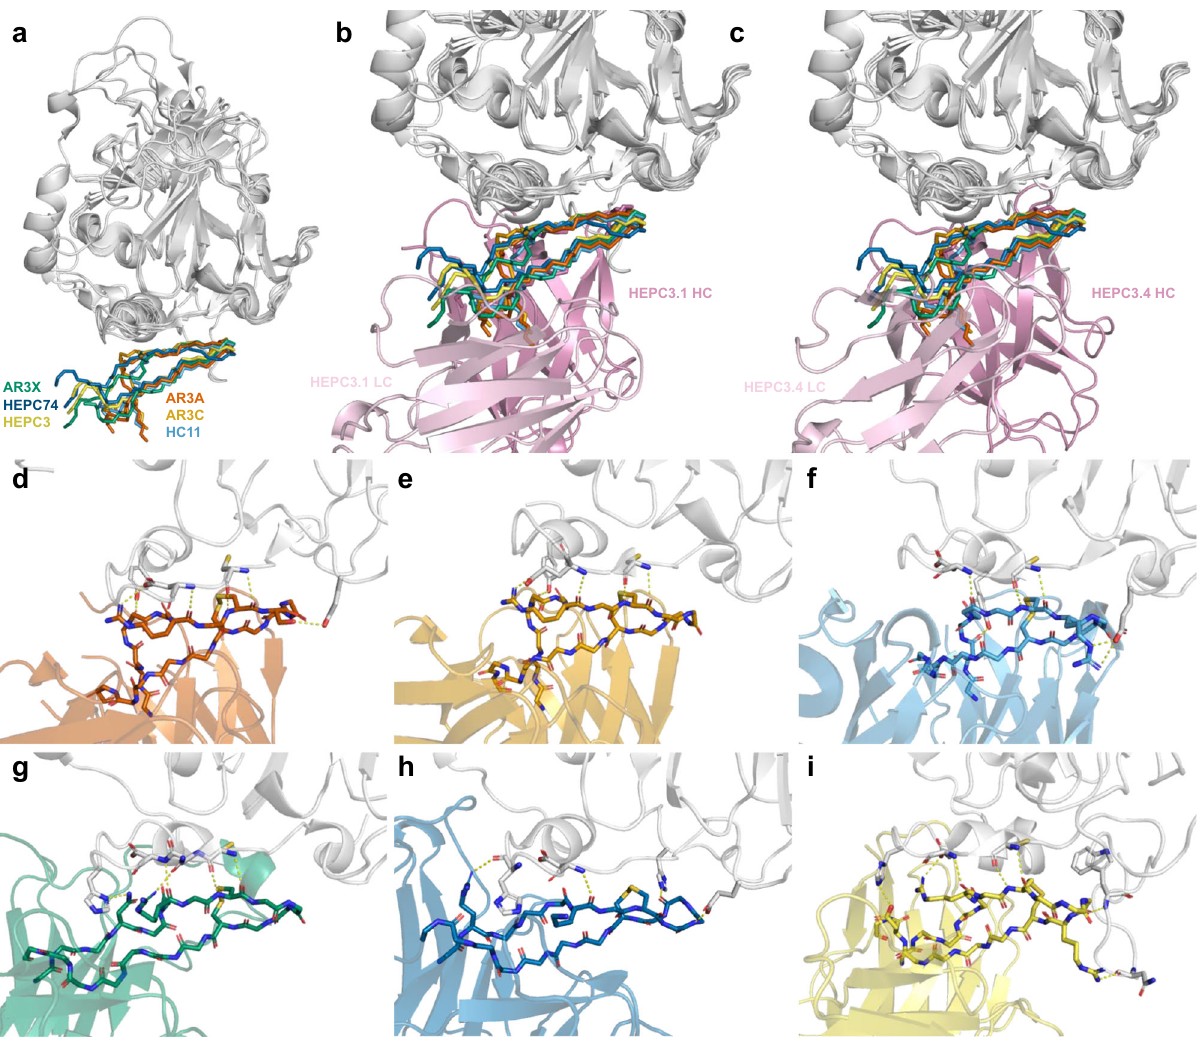
Fig. 4 Interactions of the HCV neutralizing V H 1-69 gene-encoded Abs encompassing a common HCDR3 disul fi de bond motif with the front layer of HCV glycoprotein E2. a All six Abs of the described family demonstrate the same pattern of antigen recognition mediated by their HCDR3 loop. Shown is the overlay of the HCV glycoproteins E2 from the co-crystal structures with bNAbs HEPC3, HEPC74, AR3A, AR3C, AR3X, and HC11. The glycoproteins are shown as a gray cartoon. The backbones of the HCDR3 loops of the Abs are shown as sticks. b , c The HCDR3 loop tips of the unliganded HEPC3.1 ( b ) and HEPC3.4 ( c ) Fabs were aligned with the observed common antigen recognition pattern of the V H 1-69 gene-encoded Abs with an HCDR3 disul fi de bond motif. The absence of major clashes suggests that HEPC3.1 and HEPC3.4 Abs might interact with the antigen in the same way as other front layer-speci fi c bNAbs. d – i Polar interactions between HCV glycoprotein E2 and HCDR3 loops of d AR3A, e AR3C, f HC11, g AR3X, h HEPC74, and i HEPC3 Abs, as seen in the crystal HCDR3 loop conformations (Fig. 6c ensemble 1) independent of the starting conformation (Fig. 6a columns 1 and 3, Fig. 6b and c).